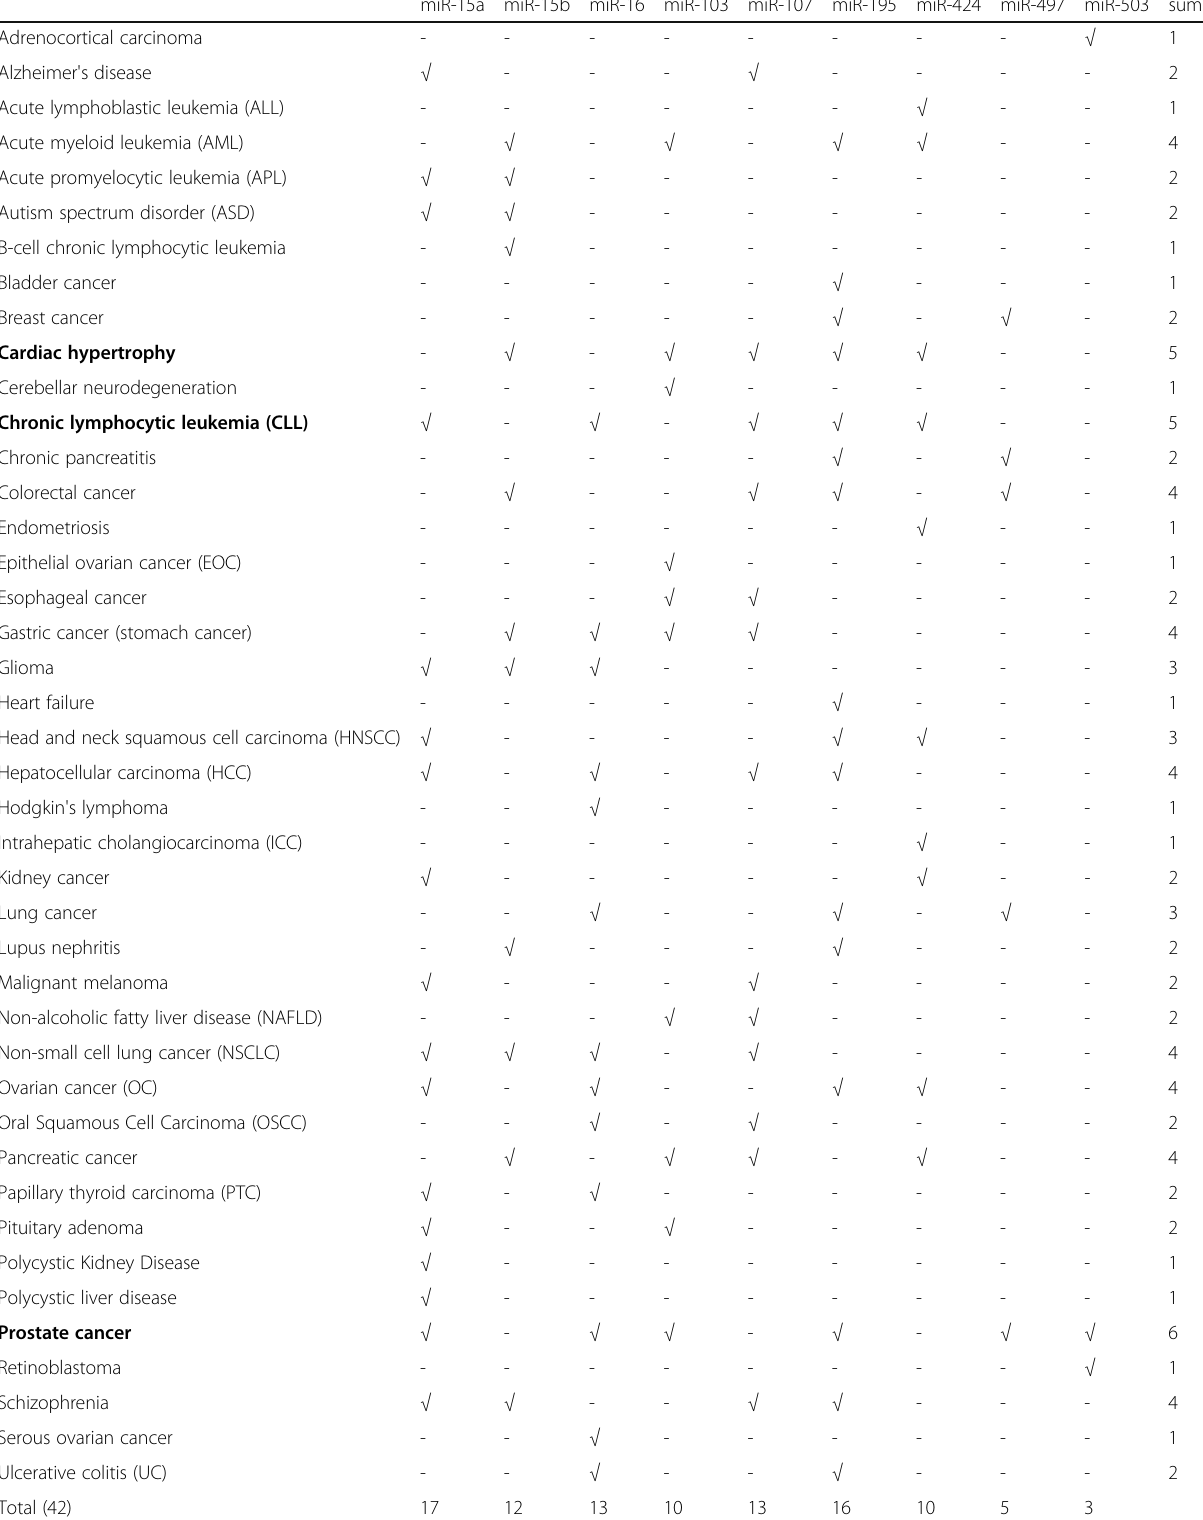
Table 3 Dysregulated miR-15/107 family in human